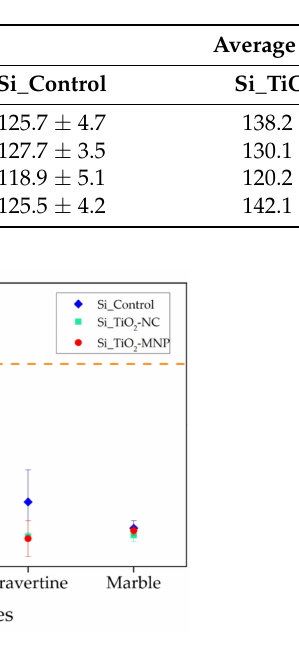
Figure 2. Mean global color variation ∆ E * between treated and untreated specimens in the CIEL* a * b * color space. The thin vertical bars represent the mean standard